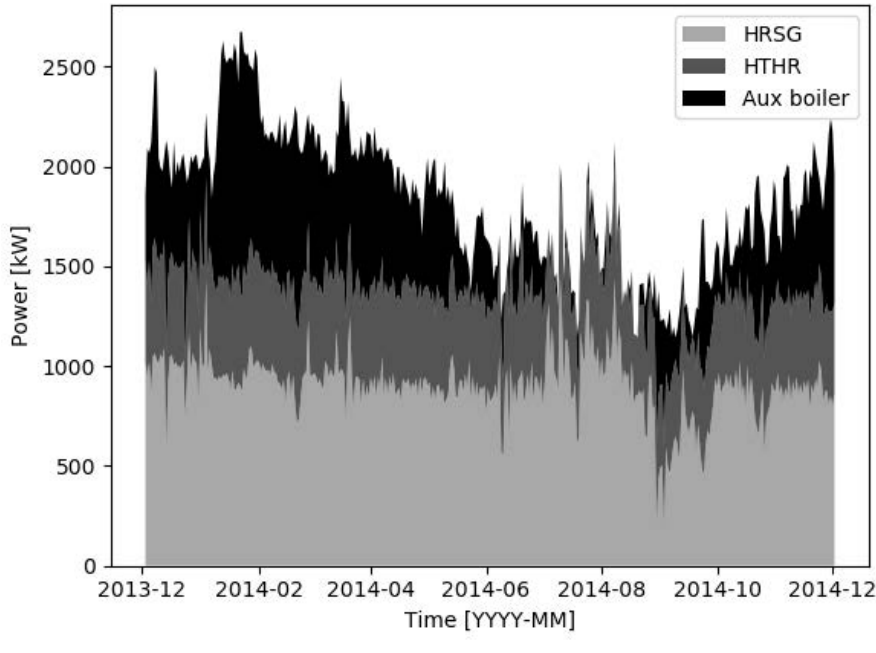
Figure 16. Time series representation of the thermal power generated from on-board heat systems. Looking on the heat demand, the HVAC preheater represents the largest contributor